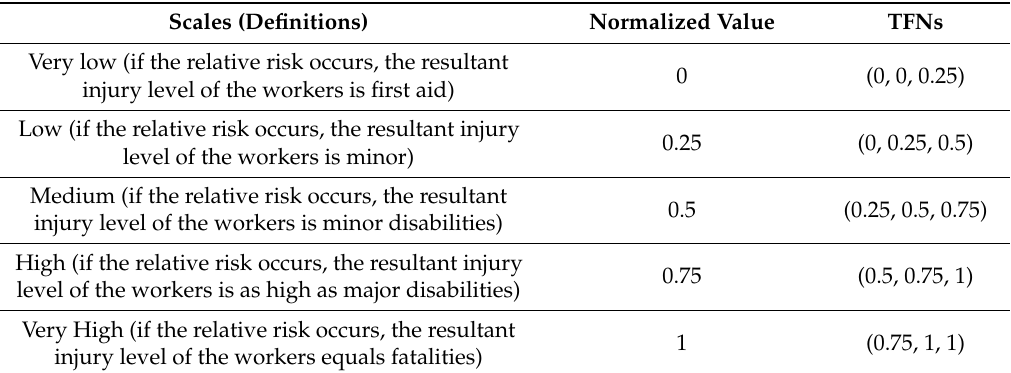
Table 3. Linguistic variables for Severity.